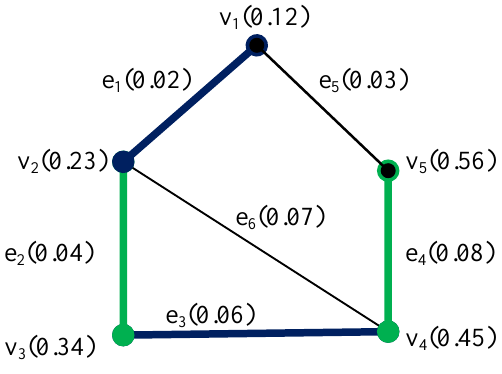
Figure 3.5: Spanning arboricity of 𝐺